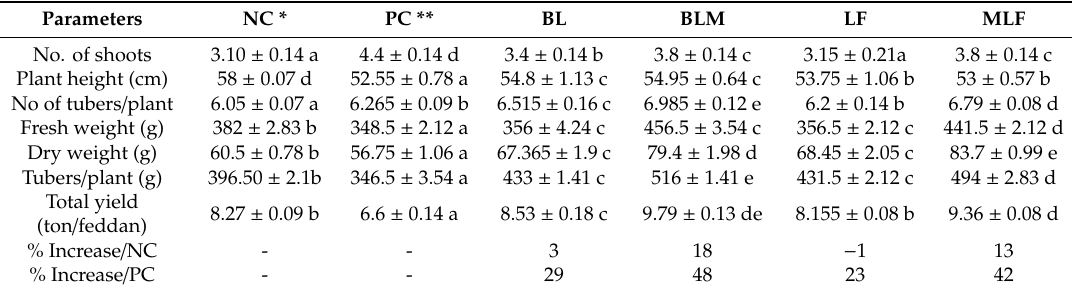
Figure 5. Scanning electron microscopy (SEM) images of potato virus PVY in its native form (control) and after being in contact with 500 µ g mL − 1 BLM and methylated lactoferrin (MLF) at room temperature for 1 h. Table 1. E ff ect of antiviral BLBLM, LF and MLF (500 µ g mL − 1 ) on the yield traits of potato plants infected with potato virus Y (PVY). Viral artificial infection was conducted 30 days after plantation and the foliar spray of the treating substance was applied 15 days after the viral